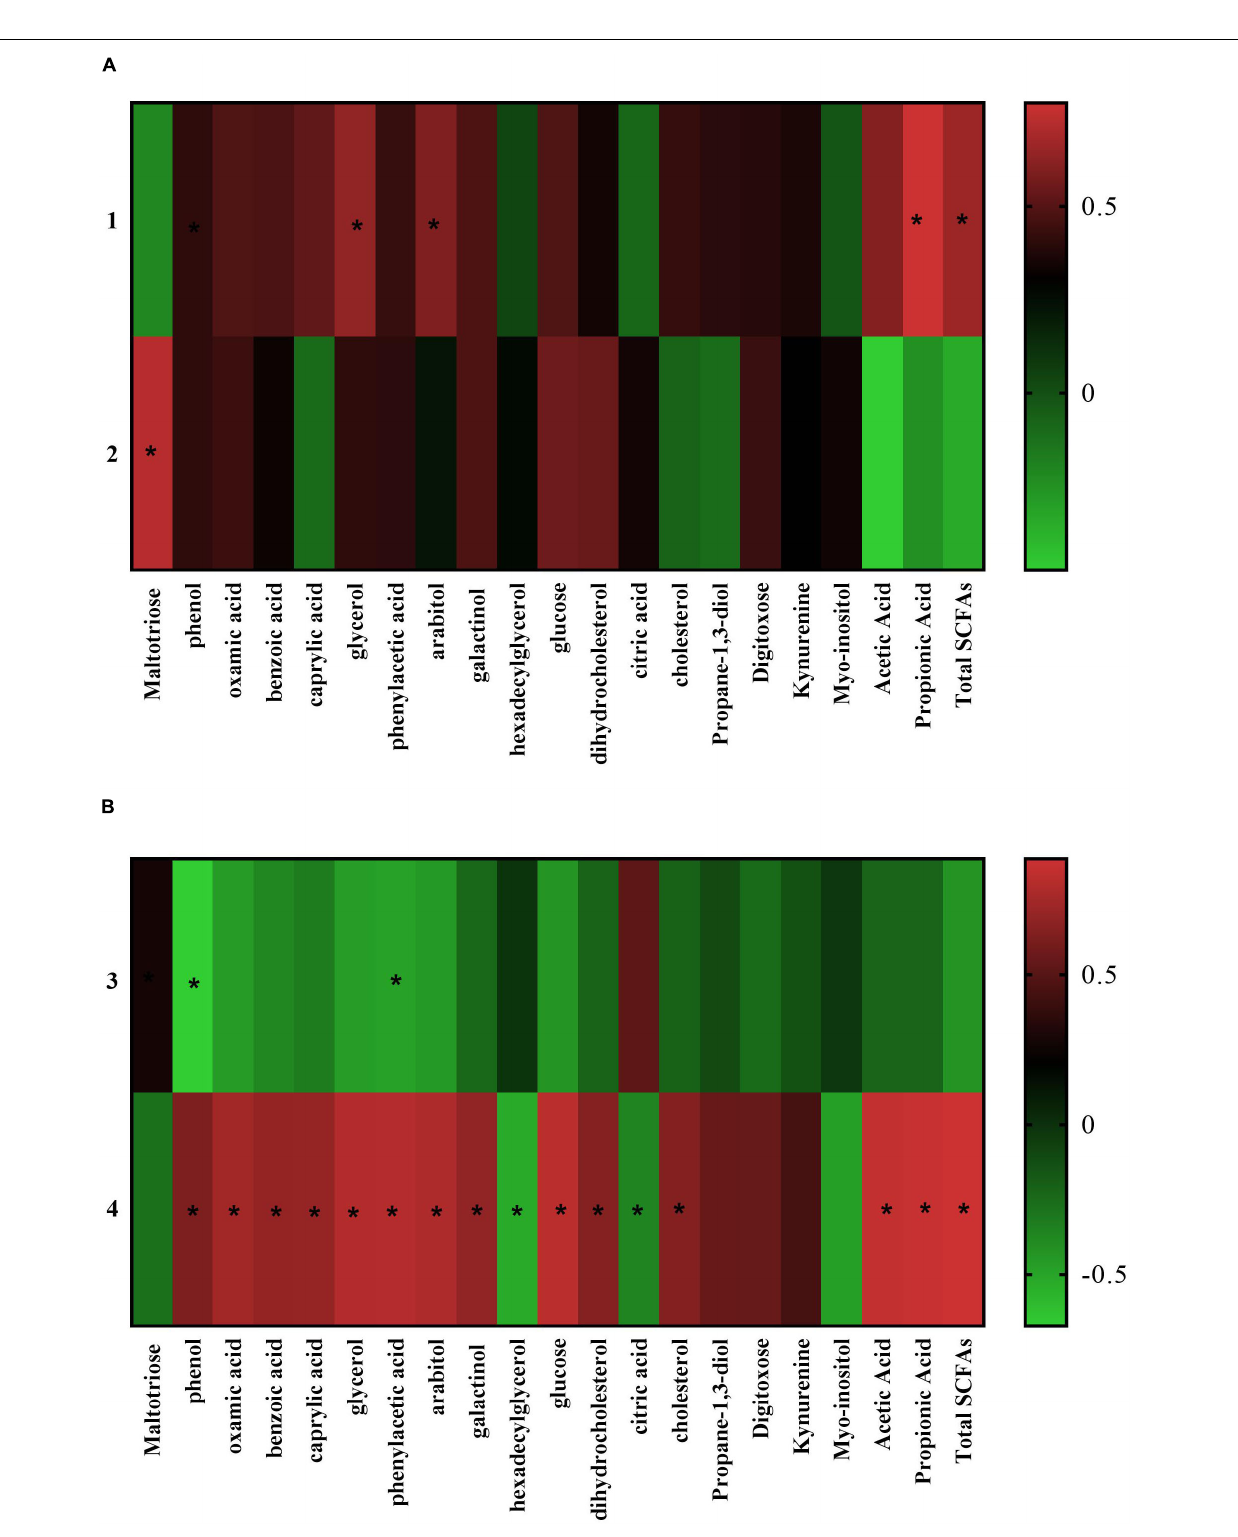
Frontiers in Microbiology |